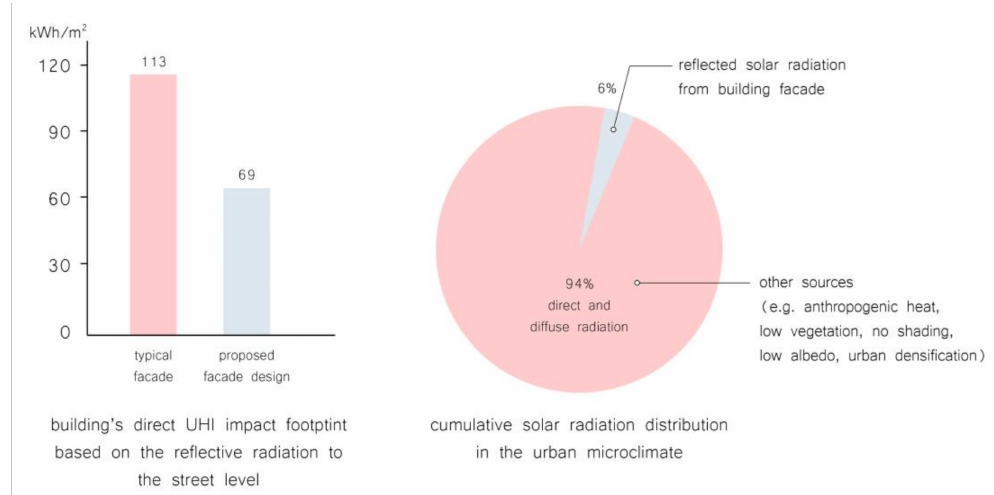
Figure 27. Charts summarizing the direct impact evaluation conclusions.